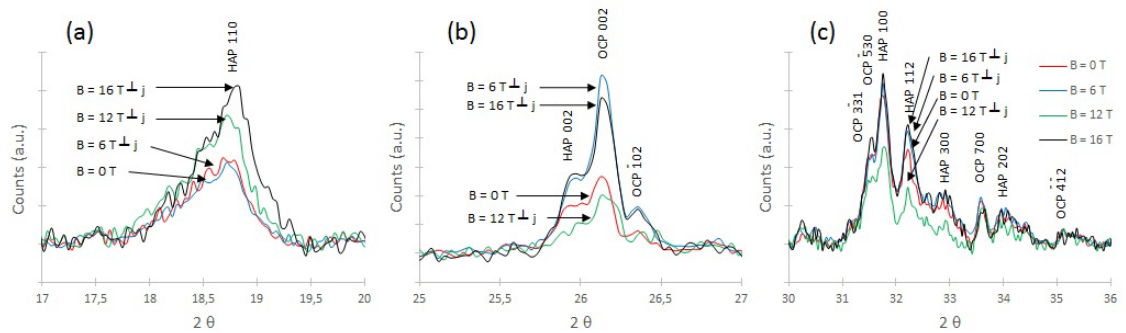
Figure 7. XRD patterns of calcium phosphate coatings products with relative intensities obtained when normalized to the most intense peak (OCP (100) at 2 θ = 4.7°) between ( a ) 2 θ = 17° and 2 θ = 20°, ( b ) 2 θ = 25° and 2 θ = 27°, and ( c ) 2 θ = 30° and 2 θ = 36°.